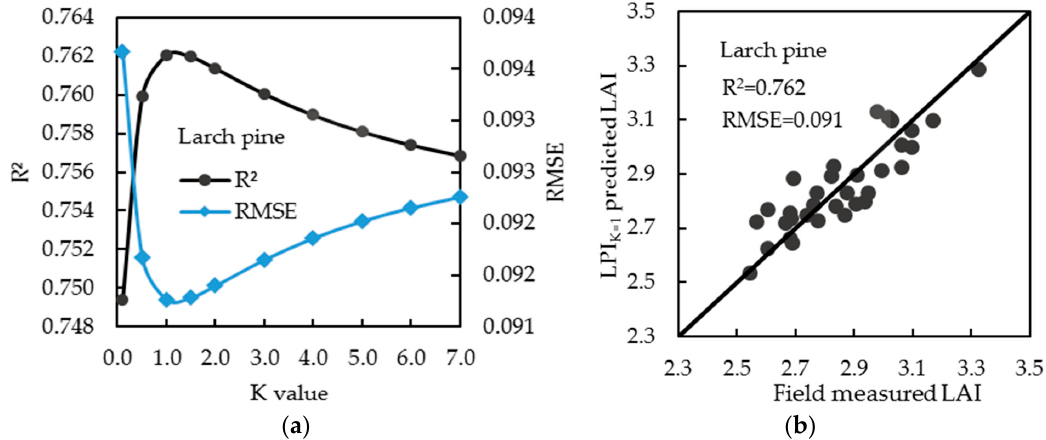
Figure 9. The LAI estimation results for Larch pine forests with target reflectance normalisation: ( a ) LAI estimation accuracy with different K values; ( b ) The relationship between the field-measured LAI and LiDAR-predicted LAI when the K value was set to around 1 (i.e., LPI K=1 ). R 2 and RMSE are values from leave-one-out cross-validation.